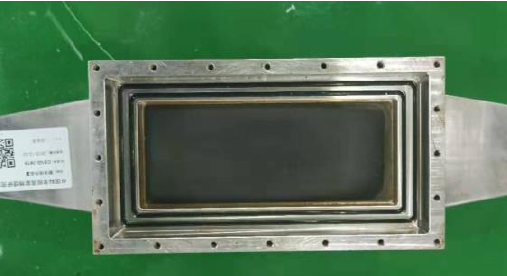
Figure 2. Scheme of rectangular coolant channel.